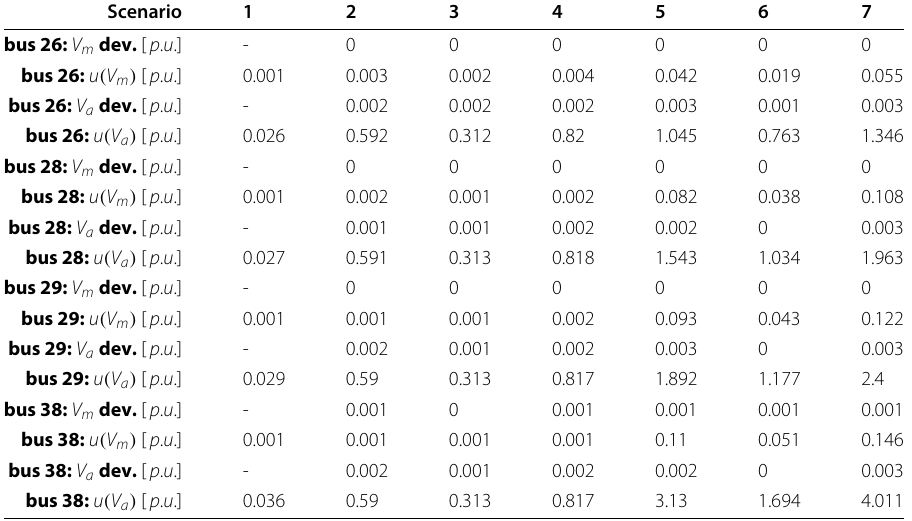
Table 2 Results for specific buses and the respective scenarios compared to the baseline Scenario 1 Scenario 1